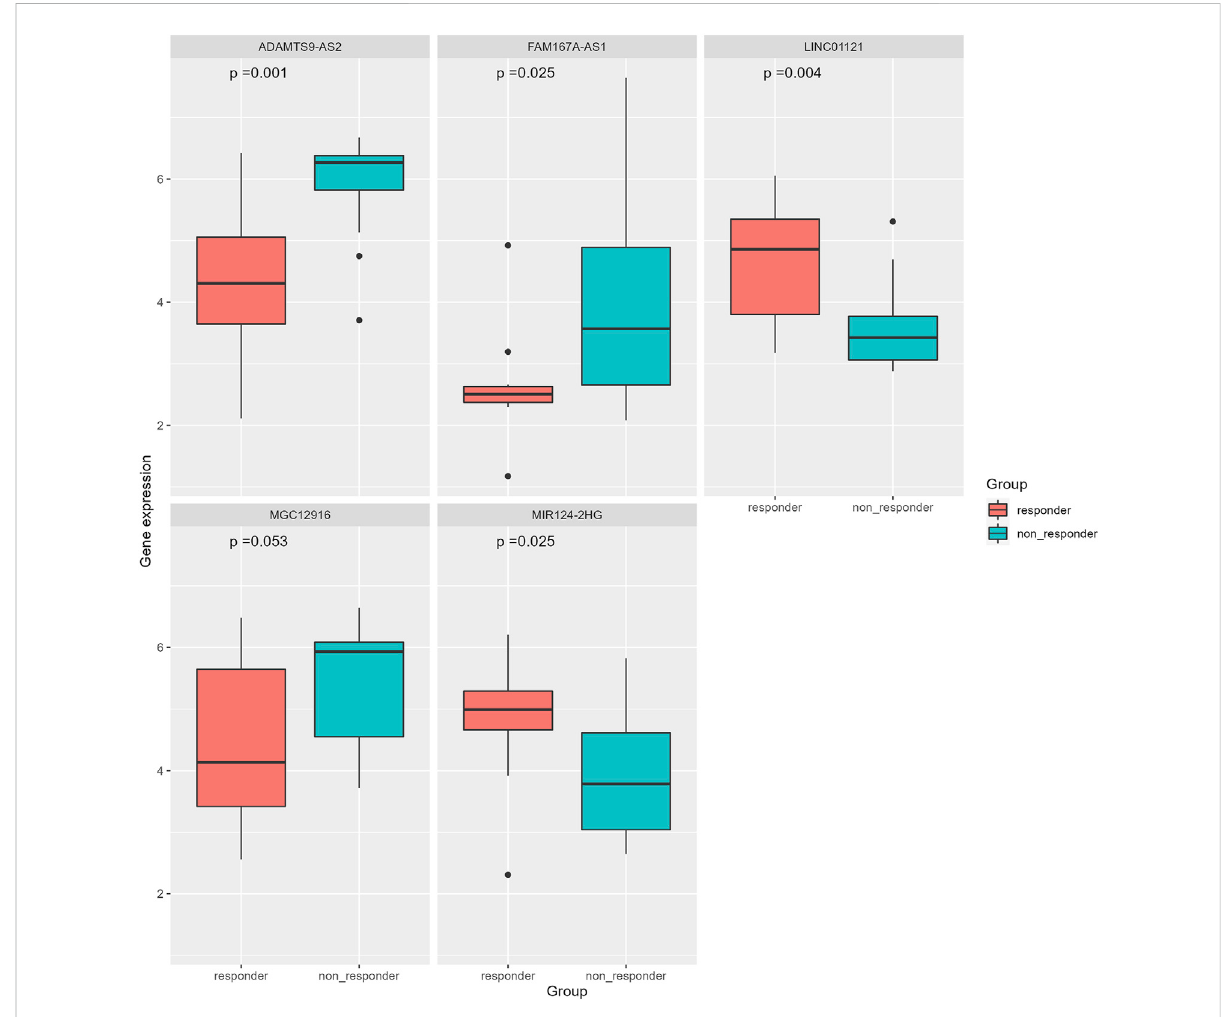
FIGURE 11 Differential expression analysis of fi ve ir-lncRNAs in GSE45670 cohort.